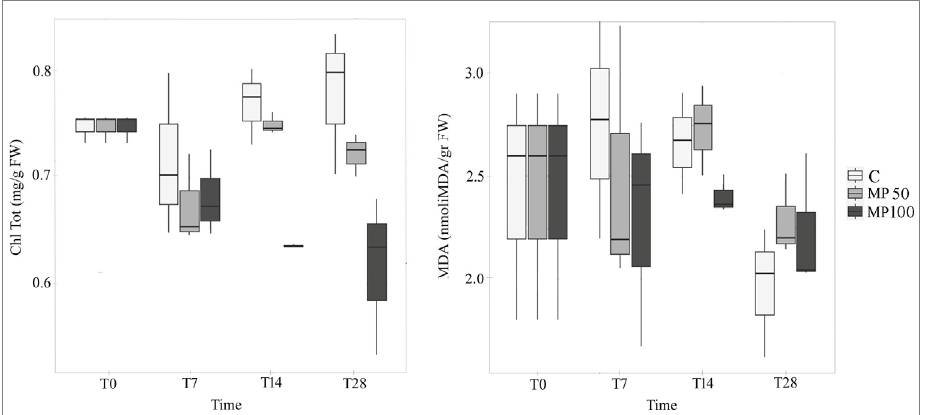
Figure 7. Total chlorophyll (Chl tot ) and malondialdehyde (MDA) content in L. minuta samples in control (C) and microplastic treatments (MP50, MP100) at different exposure times (T0, T7, T14,